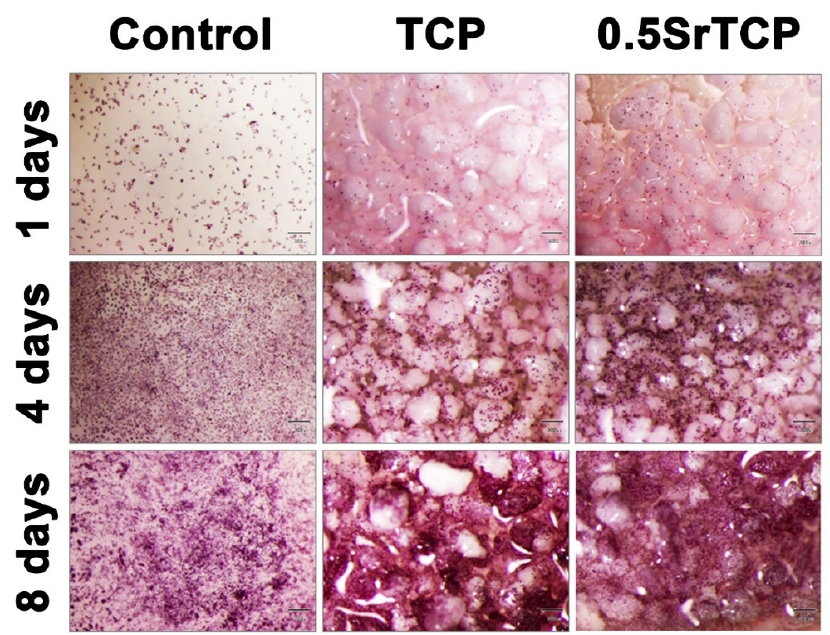
Figure 9. Population of MG ‐ 63 cells grown on control and on TCP and 0.5SrTCP ceramics. The scale bars correspond to 300 μ m.